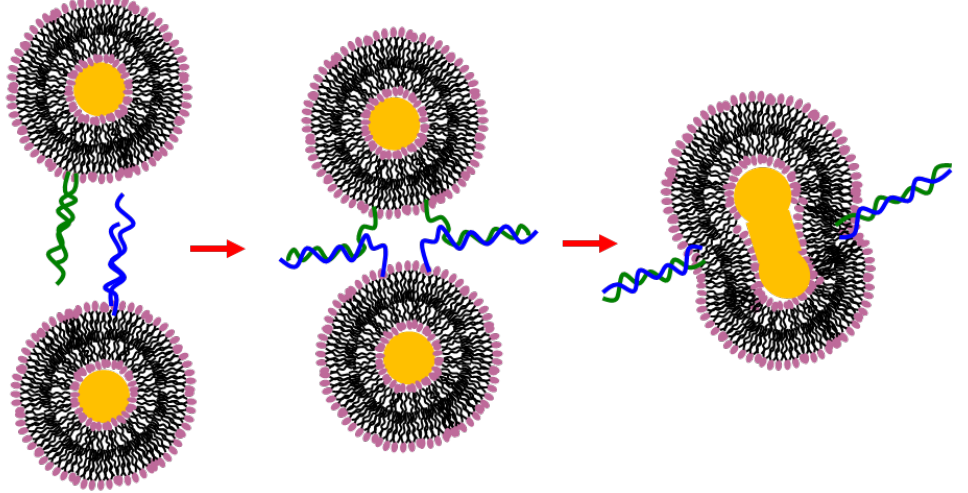
Figure 9. Schematic representation of the deoxyribonucleic acids (DNA)-induced vesicle fusion process [90].